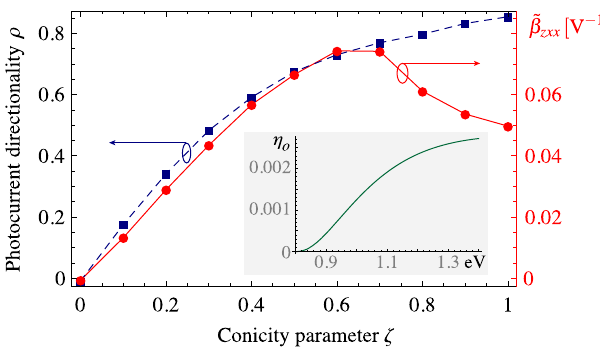
FIG. 4. Photocurrent directionality ratio ¯ ρ averaged for the photon energies between 1.0 and 1.1 eV (squares) and calculated ~ β value of the effective (circles) for the value of η for the zxx o photon energy of maximum photocurrent [the peak in Fig. 3(a)] calculated according to Ref. [35] (also shown in the inset), depending on the conicity parameter ζ